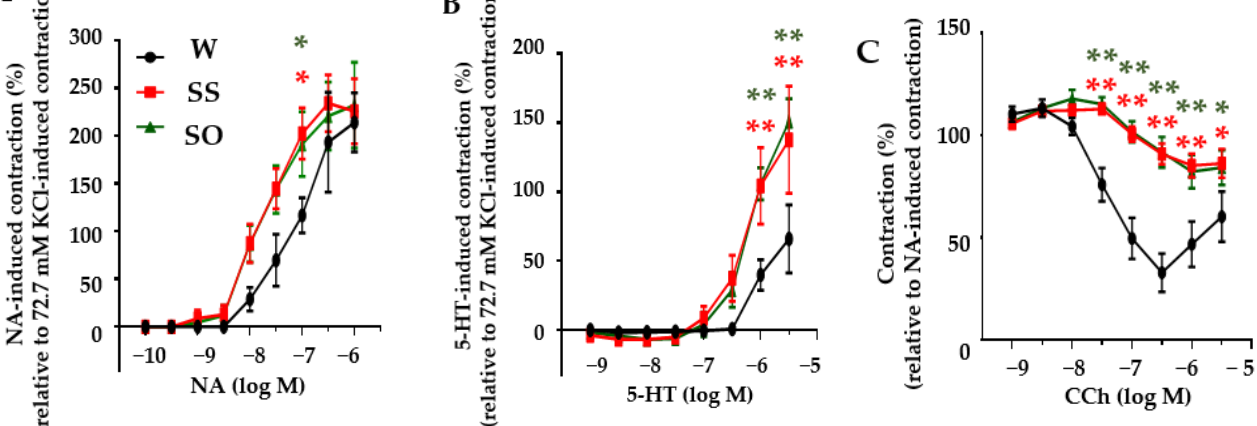
Figure 2. Human omentin-1 had no effect on agonist-induced contraction and relaxation in isolated thoracic aorta. The thoracic aorta was harvested from male SHR (65 – 68-week-old) subcutaneously injected with saline (0.14 mL/day; SS) and human omentin-1 (18 μ g/kg/day; SO) by using an implanted osmotic pump for 14 days or sham operated WKY (W). The concentration-contraction relationship for noradrenaline (NA, 100 pM – 1 μ M, A), 5-hydroxytryptamine (5-HT, 1 nM – 3 μ M, B) or carbachol (CCh, 1 nM – 3 μ M, C). ( A , B ) Agonist-induced contraction was normalized to the contraction induced by KCl (72.7 mM). ( C ) CCh was cumulatively applied after the precontraction induced by NA (30 or 300 nM) had reached a steady state, and the contraction was normalized to the NA-induced precontraction. Results were expressed as means ± S.E.M. (n = 5). * p < 0.05, ** p < 0.01 vs. W (Two-way ANOVA followed by Holm – Sidak post-hoc test).